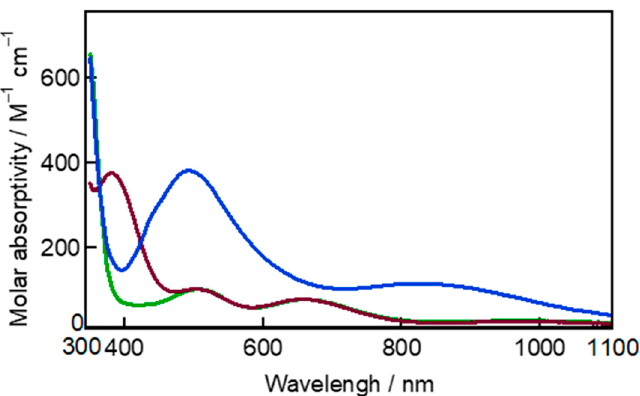
Figure 5. UV-Vis spectra of [Cu(catCl 4 )(L1 ′ )] (green), [Cu(catBr 4 )(L1 ′ )] (brown), and [Cu(catCl 4 )(L1H)] (blue) measured by CH 2 Cl 2 solution at 0 °C.